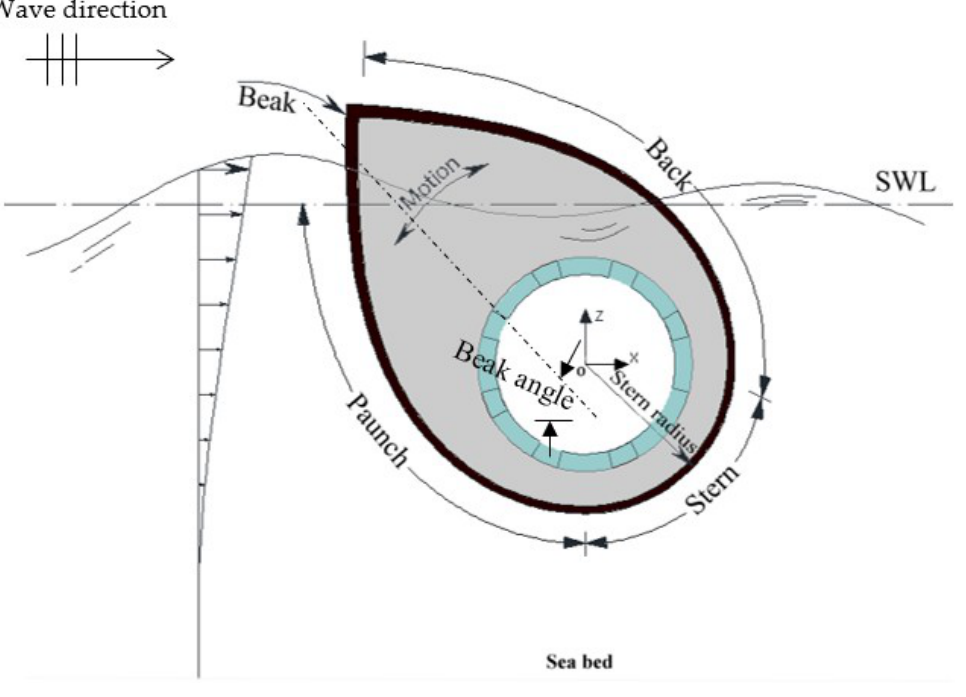
Figure 1. Schematic diagram of a WEC